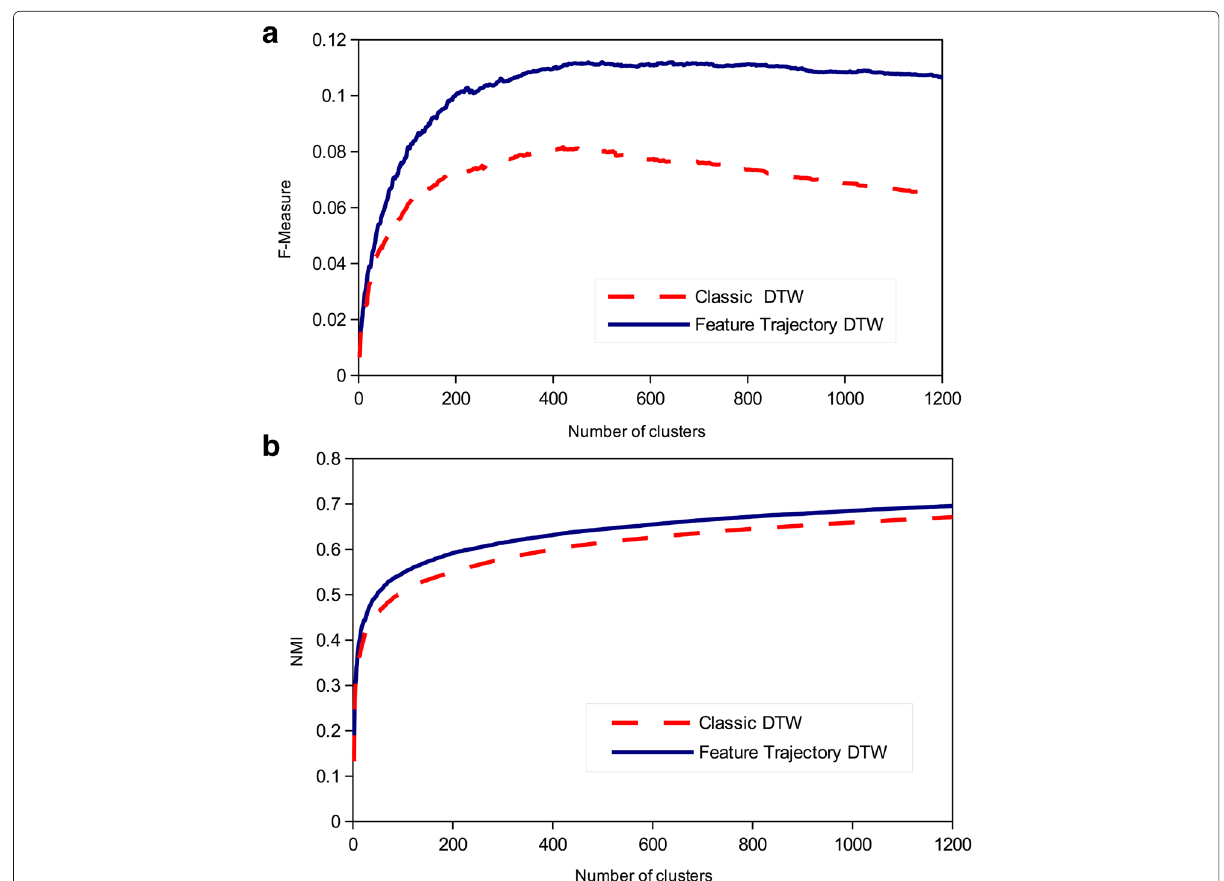
Fig. 3 Clustering performance for dataset 1 when using MFCC features in terms of a F-measure and b